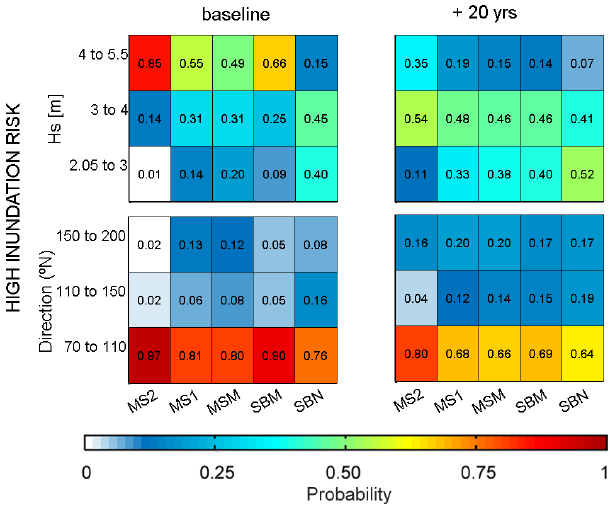
Figure 9. Probability of storm Hs and direction conditioned to the area and to highest intensity inundation risk, i.e. moderate to high risk to life together with high structural damages ( ≥ 60%). Note that extreme risk to life and damages over 90% are not present for the study site. Results must be read as individual vertical histograms (one histogram per